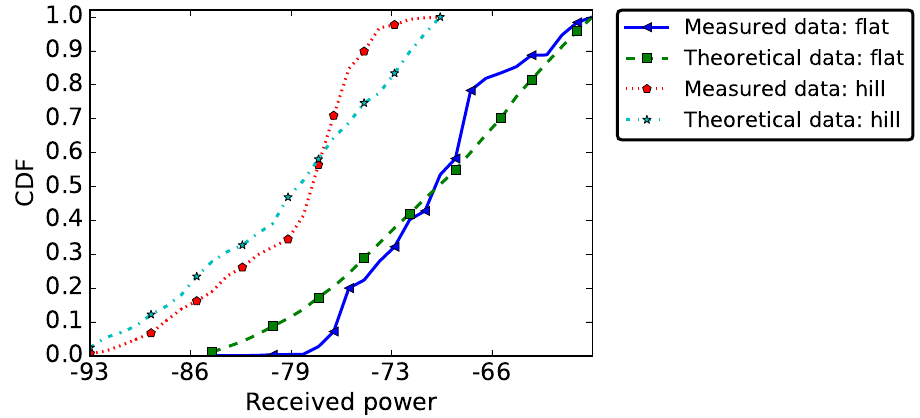
Figure 16. RSSI Validation: Empirical and Theoretical